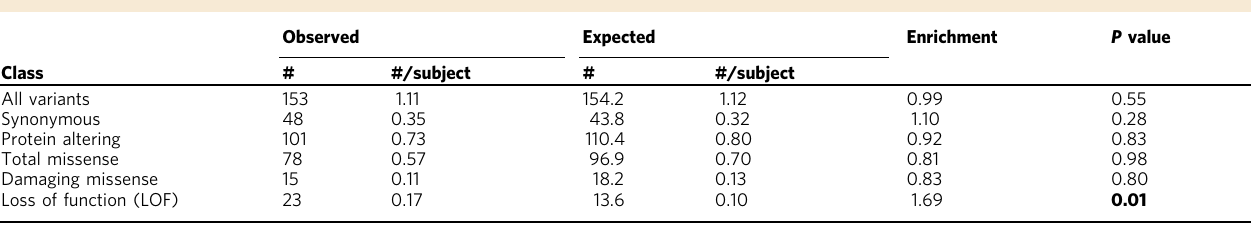
Table 1 Burden of de novo variants in 138 probands with sporadic CFM.